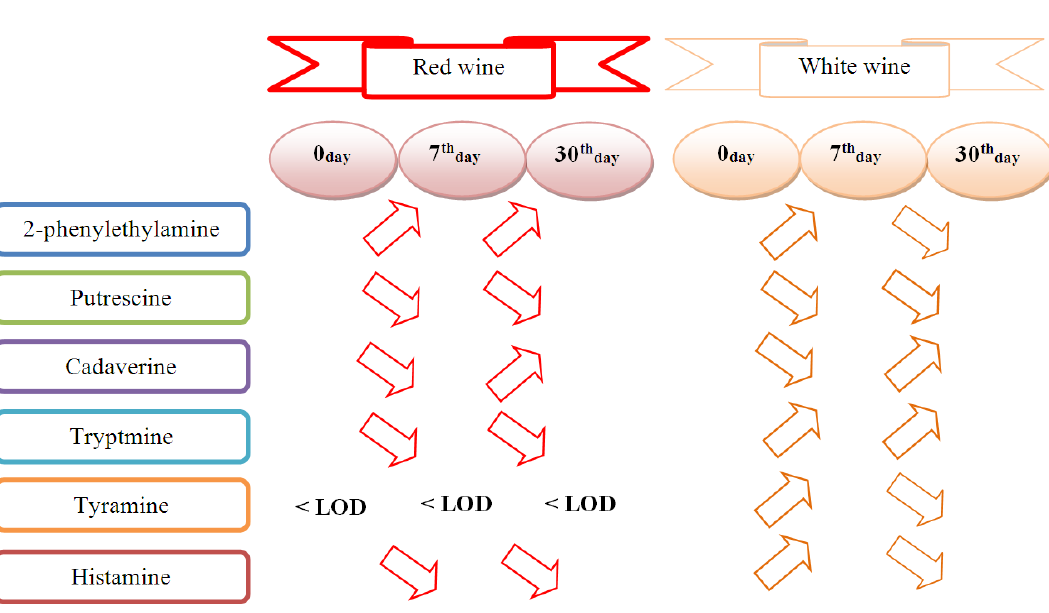
Figure 1. Schematic representation of the way BAs concentration changed over time.